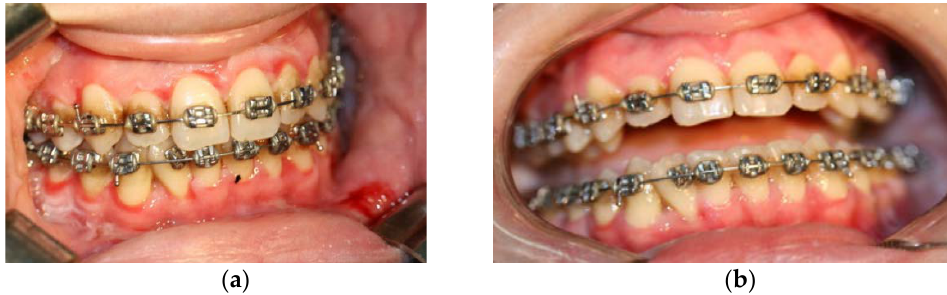
Figure 1. DG in a patient with PV. The patient was not allergic to nickel, and did not have a history of other allergies. ( a ) Intense erythema, desquamation and erosions of the attached gingiva—before treatment. ( b ) Remission of erythema and healed erosions after systemic corticosteroid treatment. The diagnosis is based on the clinical appearance of the lesions corroborated with paraclinical examinations. Tzanck cytodiagnosis reveals acantolytic cells, i.e., segregated and dysmorphic keratinocytes, with shape and volume anomalies, monstrous nucleus and diminished cytoplasm. Histopathological examination reveals the presence of slit spaces above the epithelial basal layer. Acantolytic cells are present inside these slits. In